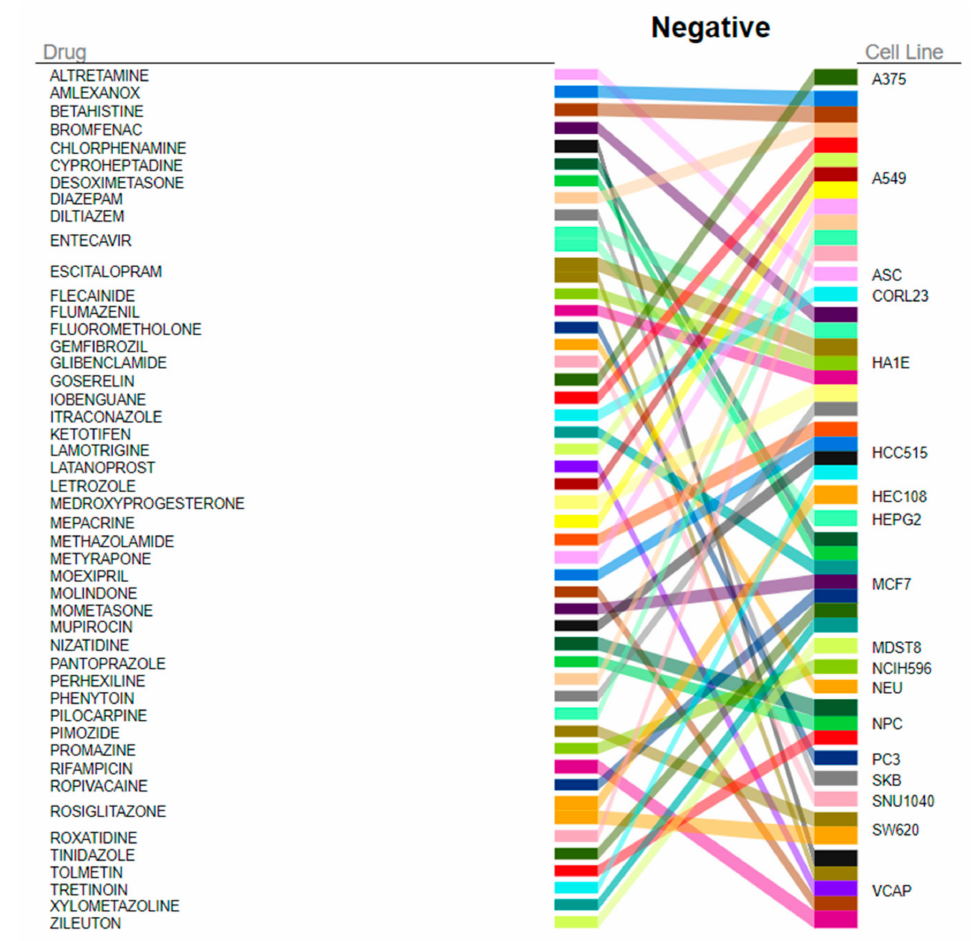
Figure 5. The top 30 FDA-approved target compounds identified from all cell lines by QUADrATiC software that could potentially reverse the recGBM phenotype.